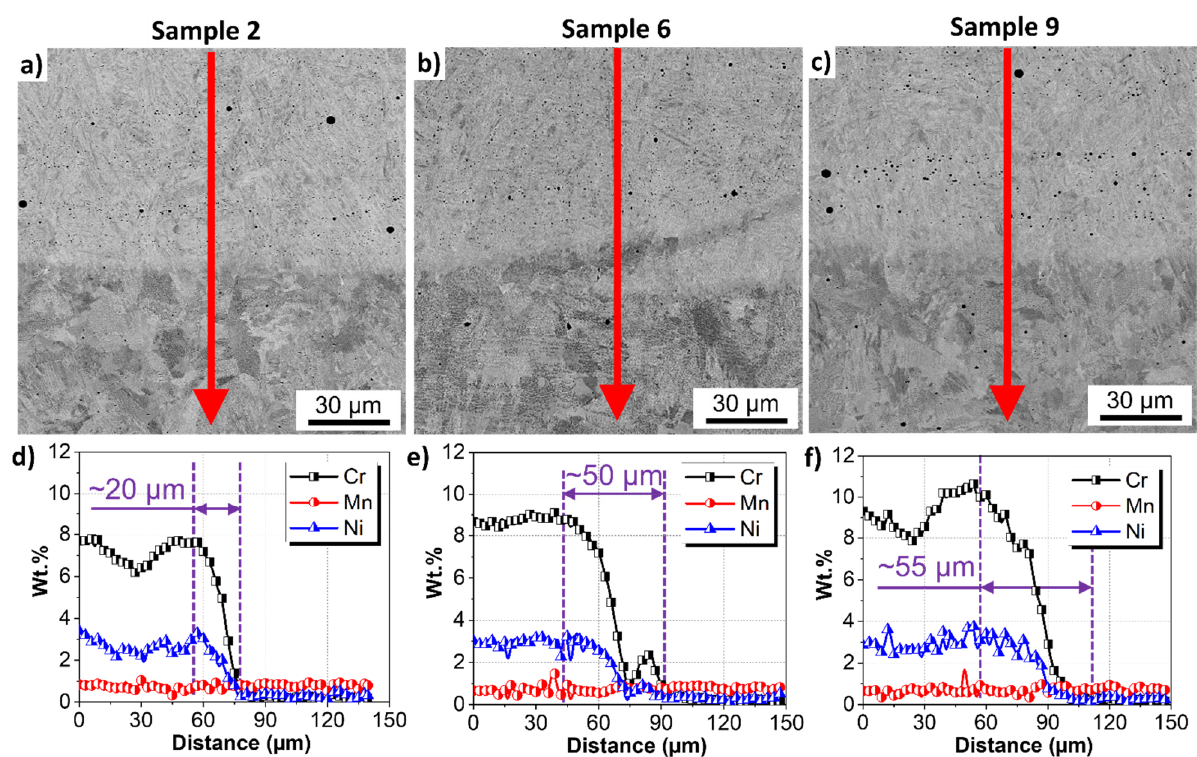
Figure 14. Chemical analysis of the clads. EDXS linescans for ( a , d ) sample 2; ( b , e ) sample 6, ( c , f ) sample 9. Cr, Mn, and Ni are shown, and Fe was identified as the remaining element.